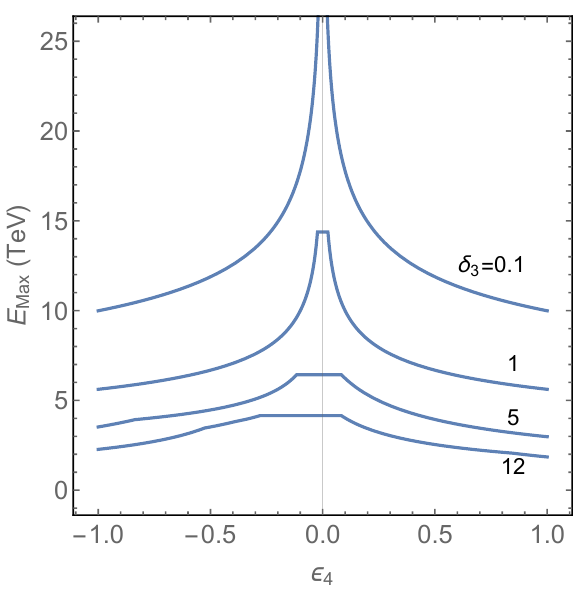
Figure 3 . Unitarity violating scales from processes that depend on δ 3 and δ 4 as a function of the fractional deviation (cid:15) from the dimension-6 SMEFT prediction (see eqs. (2.15) and 4